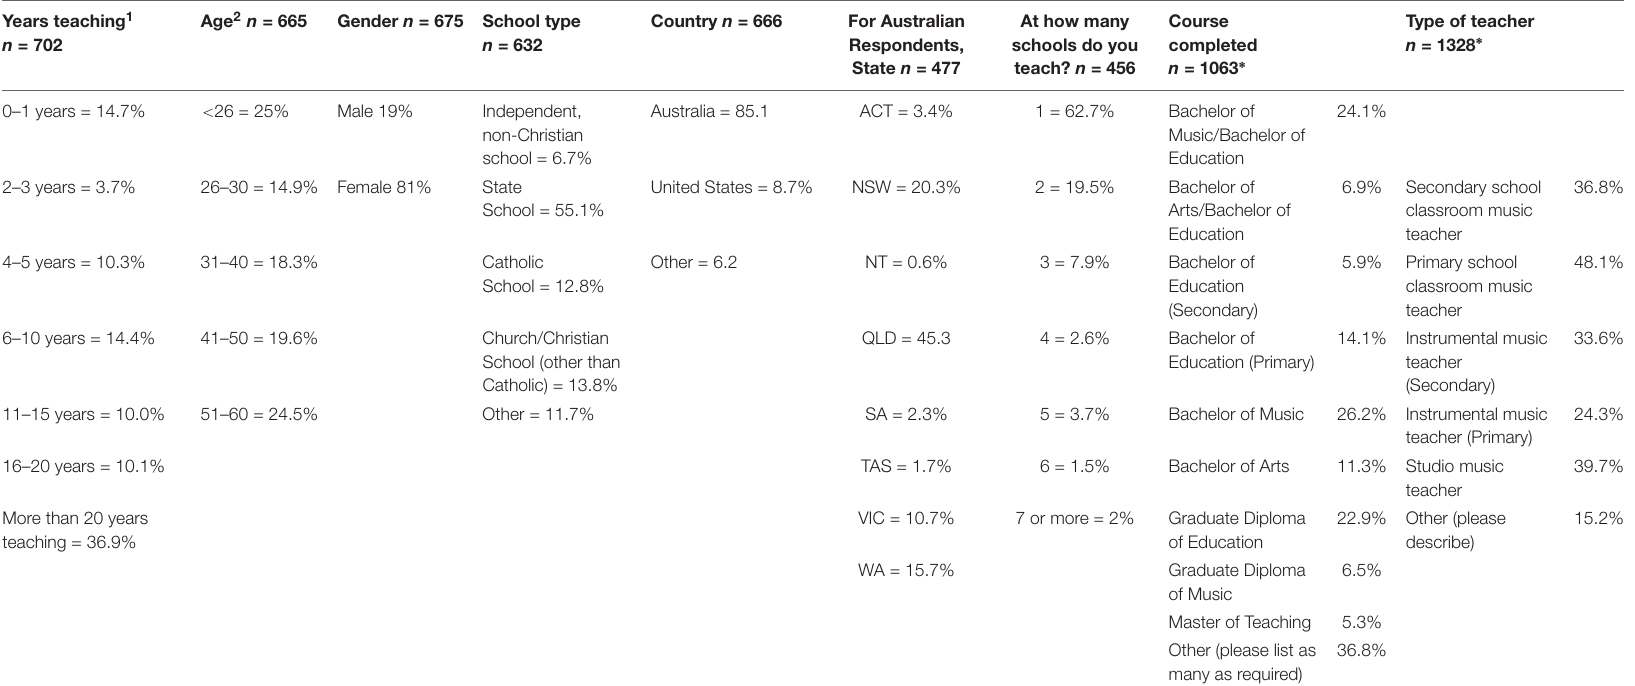
TABLE 2 | Demographic information of